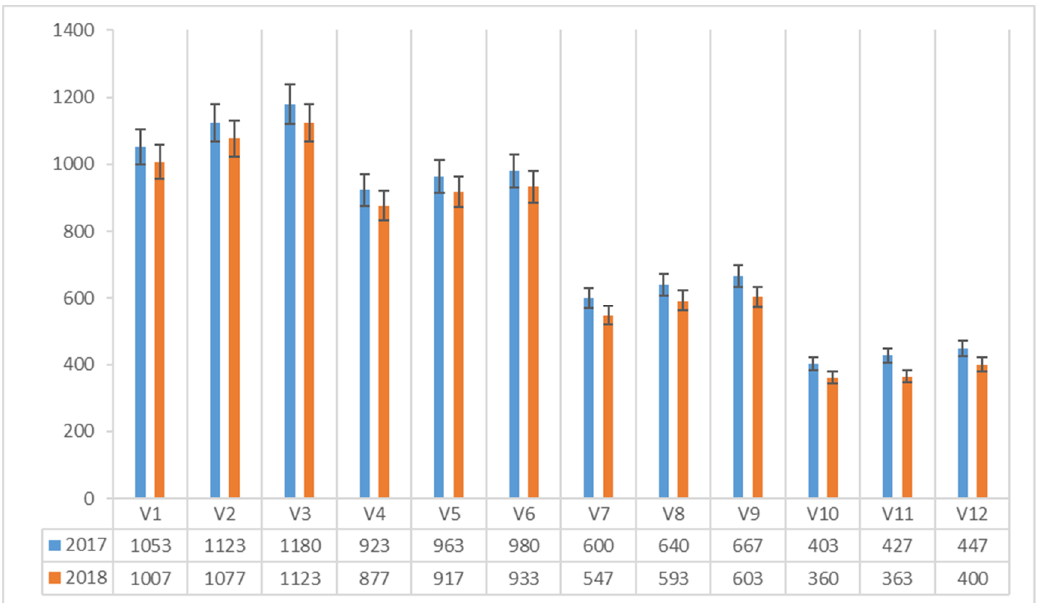
Figure 3. Vitamin B 1 content of Agaricus blazei Murrill mushrooms (μg 100g −1 dm) in two years of experiments.